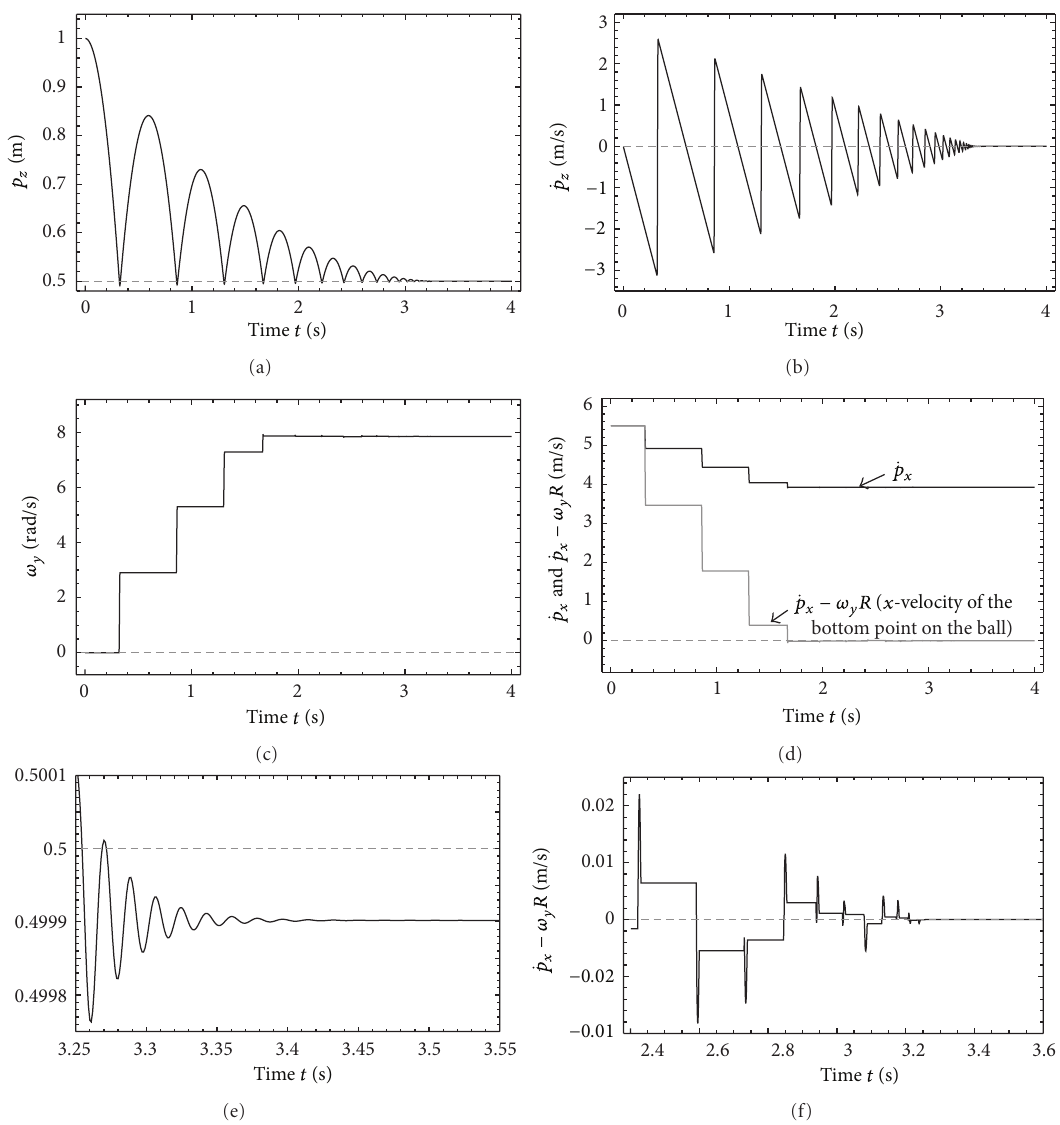
Figure 7: Simulation results of Example I by using (37) integrated by RK4 with the timestep size 0.001 s. The parameters are chosen as